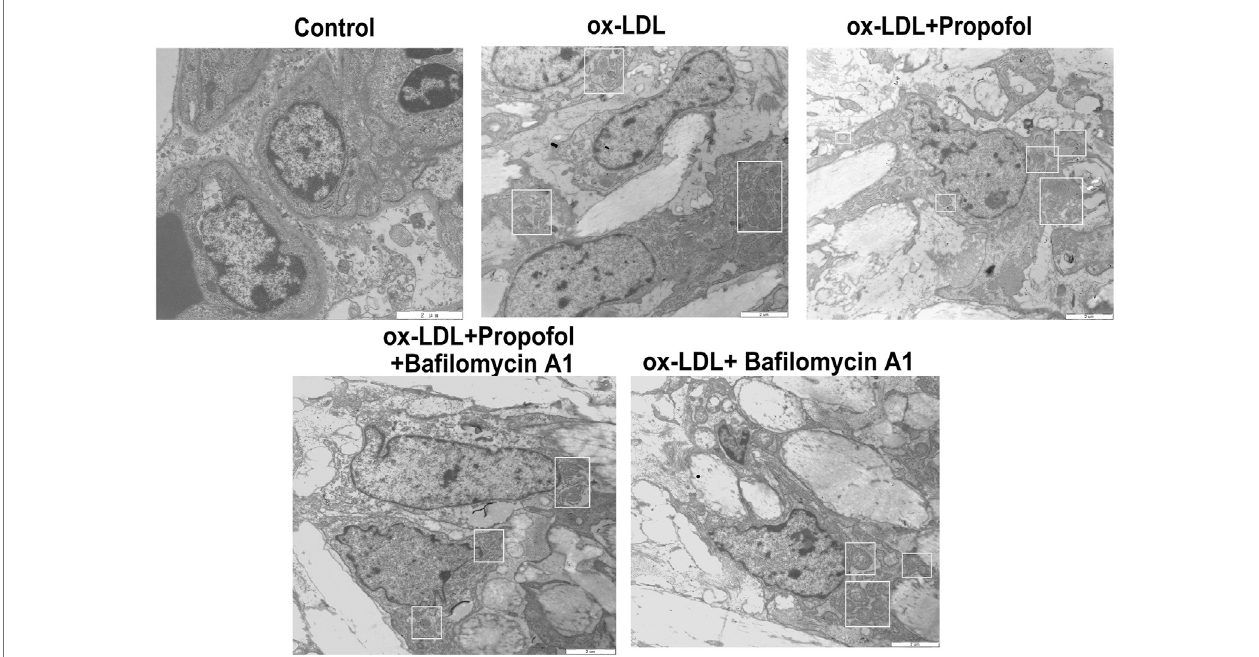
FIGURE5| Transmissionelectronmicroscopefordetectionoftheautophagosomesin100 ° μ g/mlox-LDL-exposedHUVECstreatedwith100 ° μ MPropofoland/or Ba fi lomycin A1. Autophagosomes are boxed. Bar (cid:2) 2 ° μ